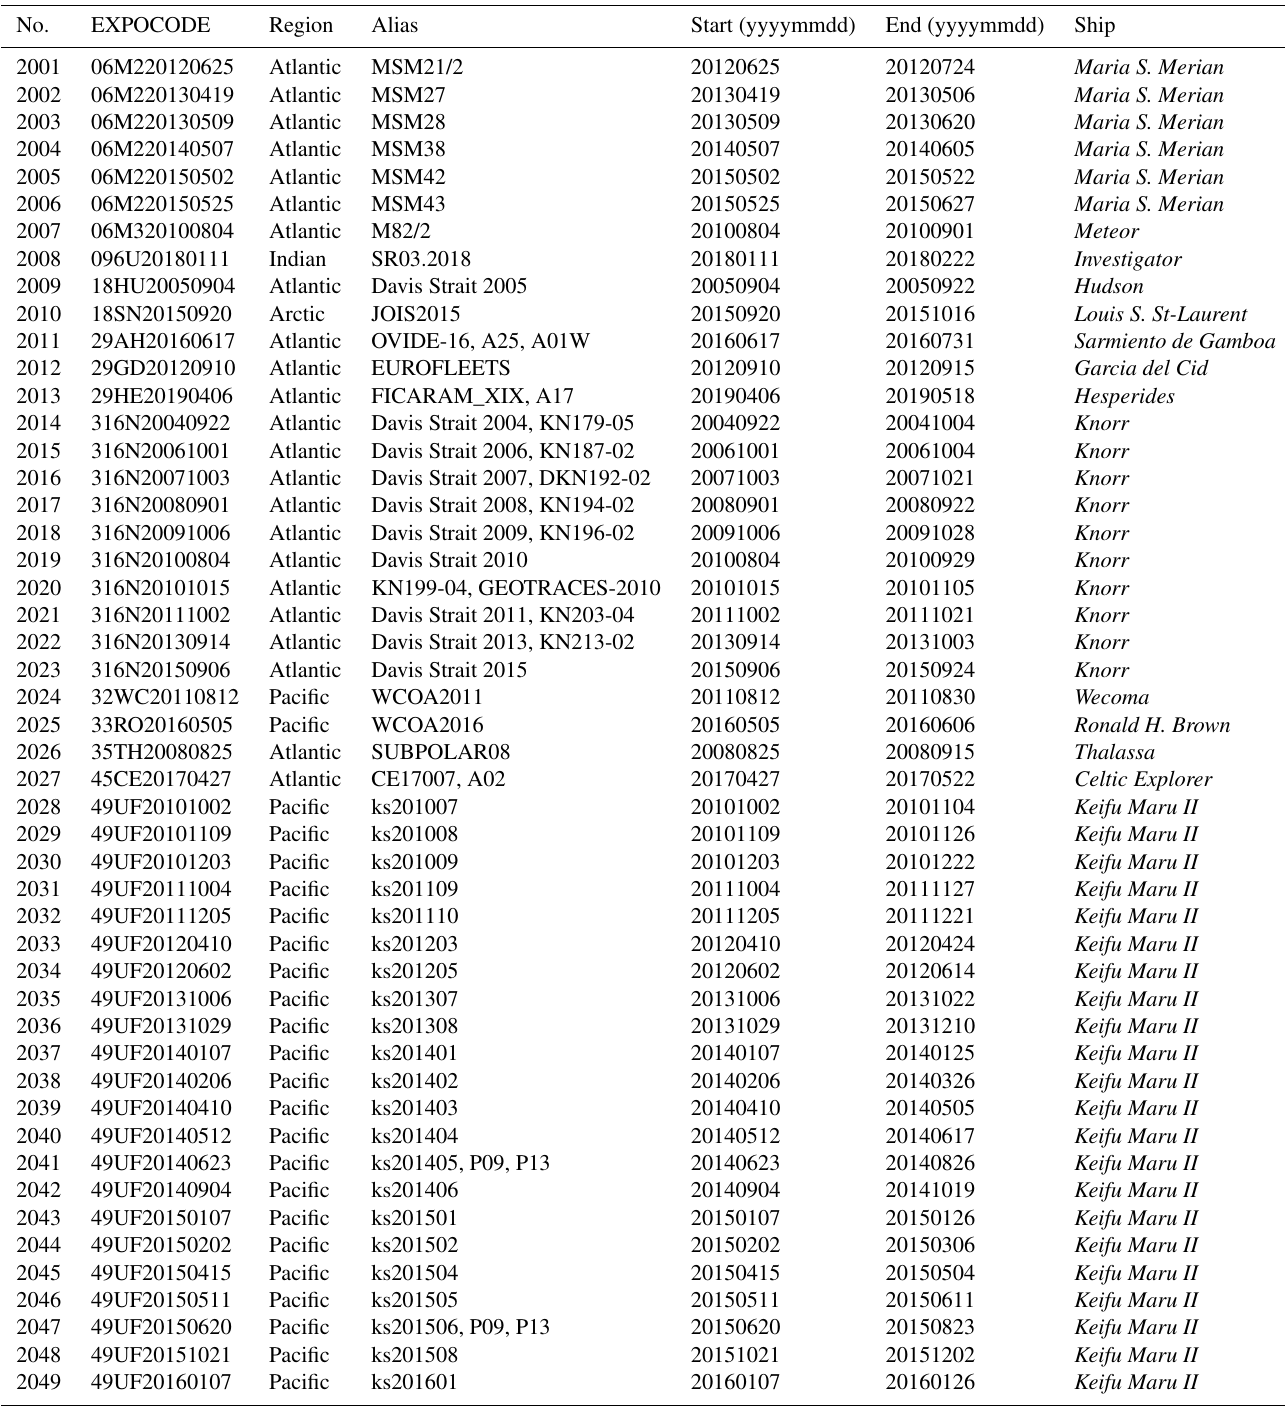
Table A1. Cruises included in GLODAPv2.2020 that did not appear in GLODAPv2.2019. Complete information on each cruise, such as variables included and chief scientist and principal investigator names, is provided in the cruise summary table at